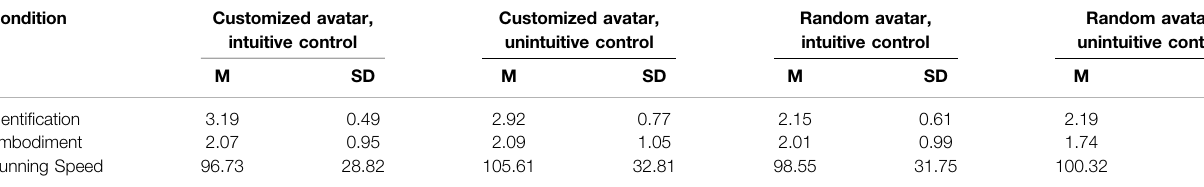
TABLE 2 | Means and standard deviation for dependent variables in each condition.